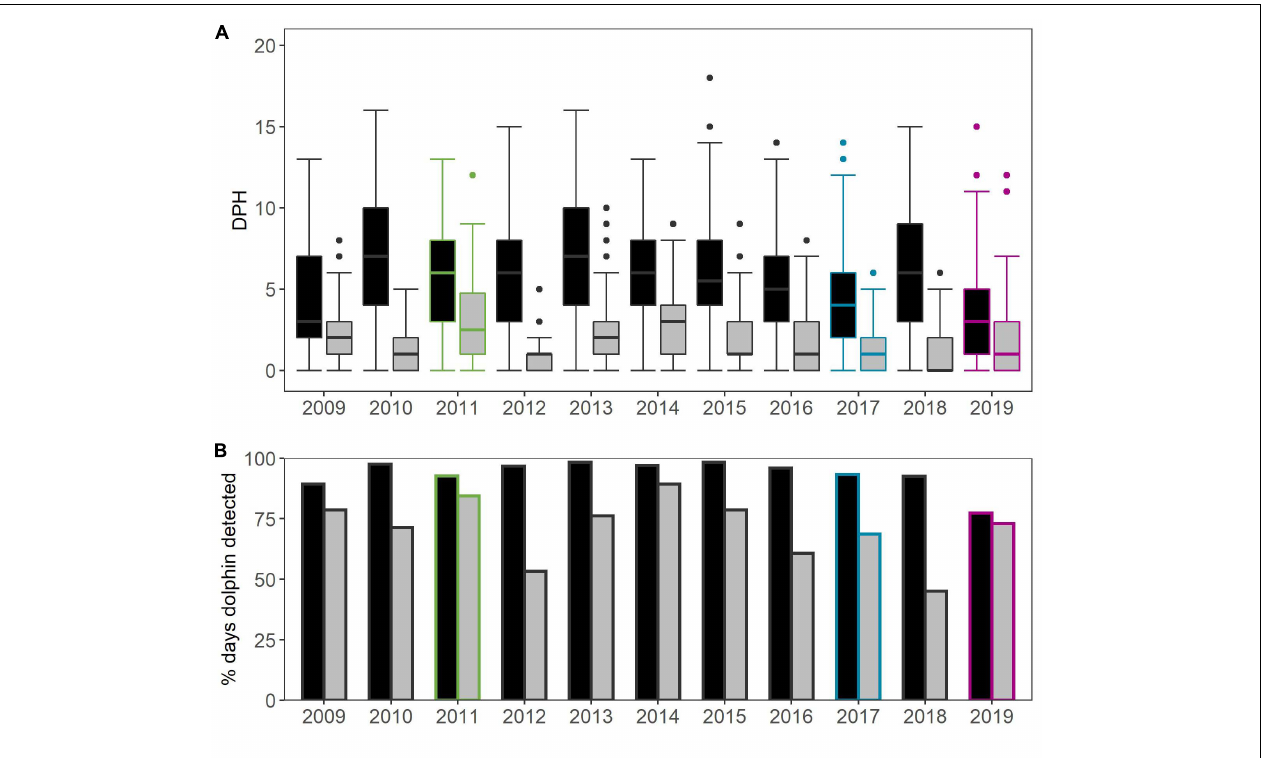
FIGURE 2 | Inter-annual variation in (A) dolphin Detection Positive Hours per day and (B) percentage of days that dolphins were detected in Reference Area (black) and Impact Area (gray). Data from August-September 2009 to 2019 from the 4 long-term CPODs. Colored borders indicate years when offshore activities took place (2011: 2D seismic survey; 2017: Beatrice wind farm construction; and 2019: Moray East wind farm